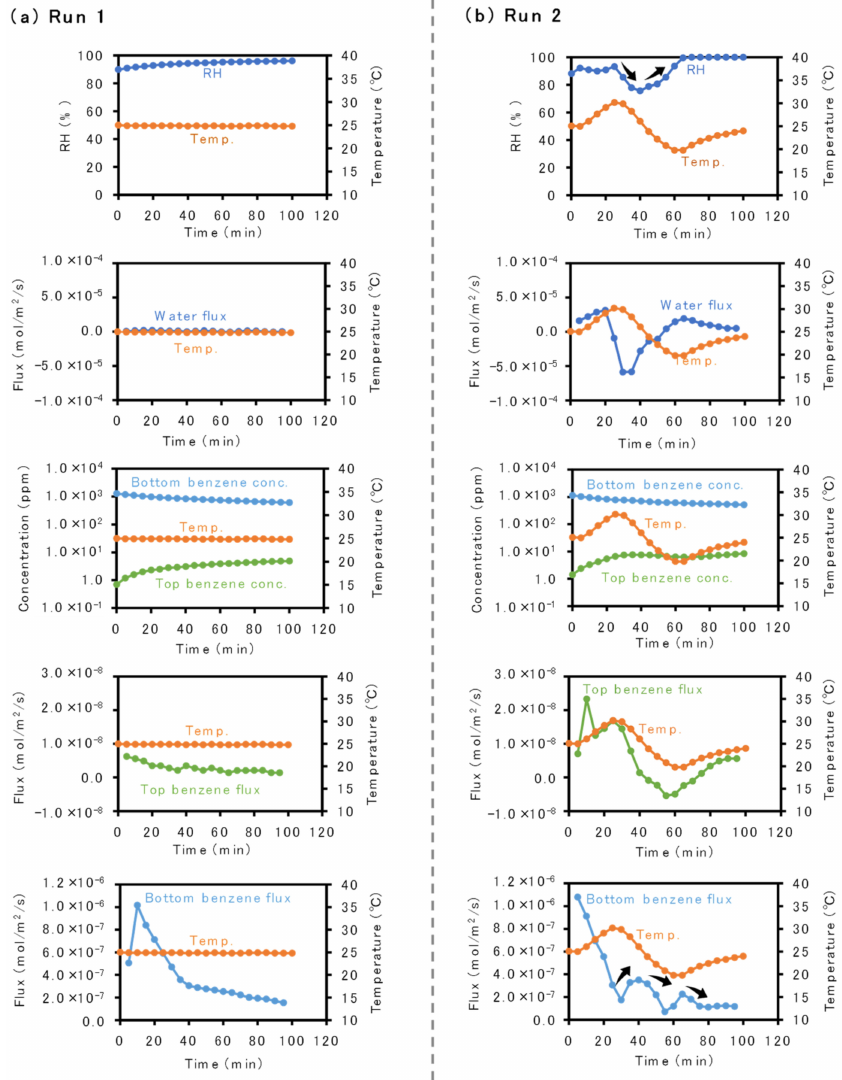
Figure 4. Changes in relative humidity (RH) and corresponding water flux, top and bottom ben- zene concentrations, and corresponding top and bottom benzene fluxes in ( a ) static temperature experiment Run 1 and ( b ) dynamic temperature experiment Run